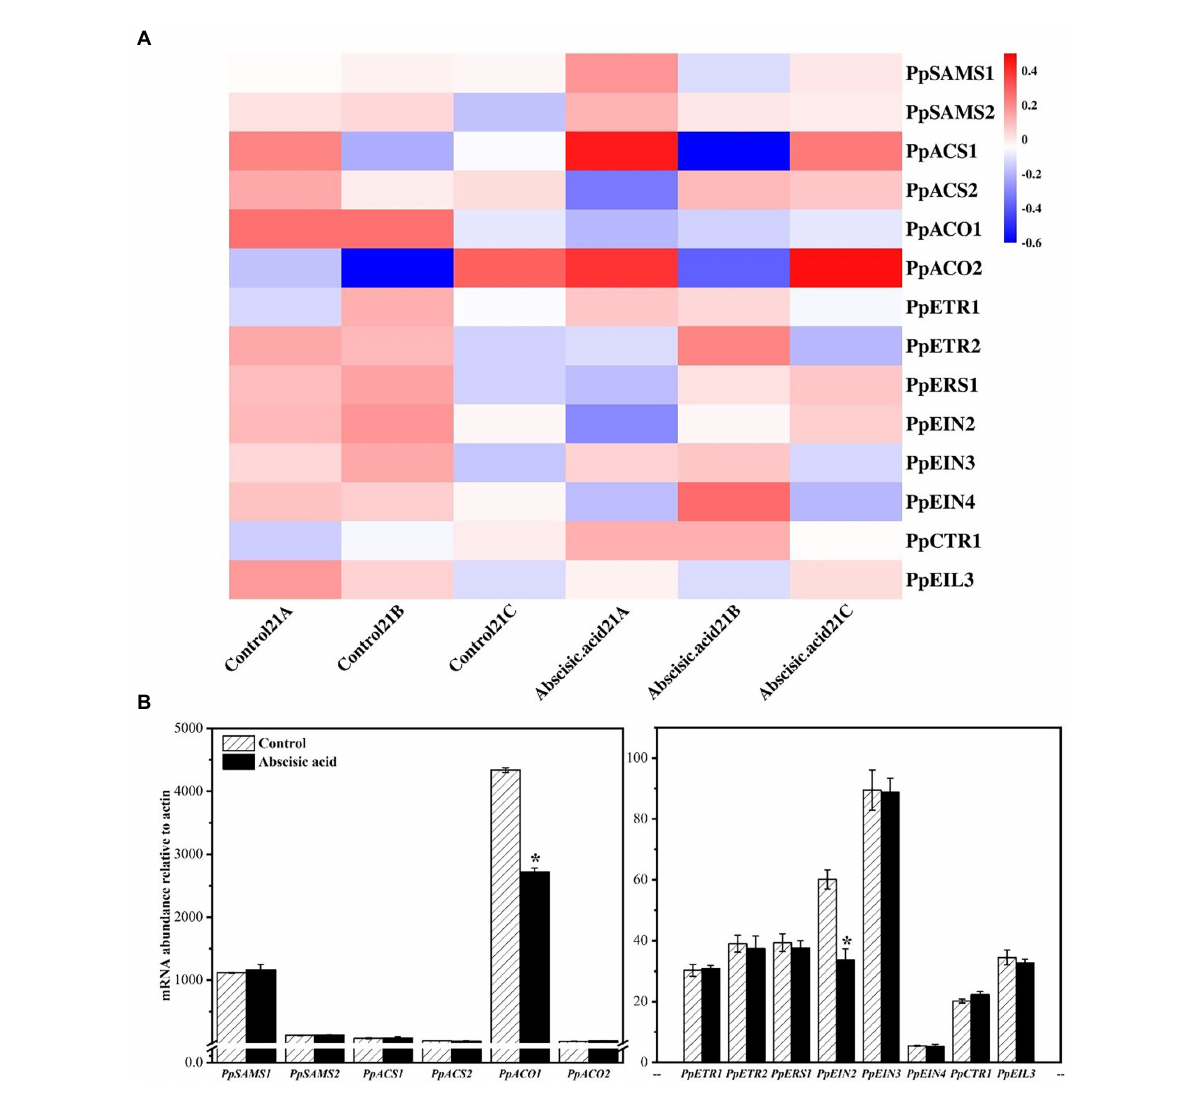
FIGURE 4 Effect of abscisic acid (ABA) treatment on the mRNA abundance of genes related to ethylene biosynthesis and the ethylene signaling pathway in fruit stored at 4 ° C. (A) Heat map showing transcript abundances of differentially expressed genes as determined by RNA-seq. (B) Validation of mRNA abundances as determined using RT-qPCR. Data are means of three biological replicates ±SE. The symbol ( * ) indicates significant differences among different treatments at p <